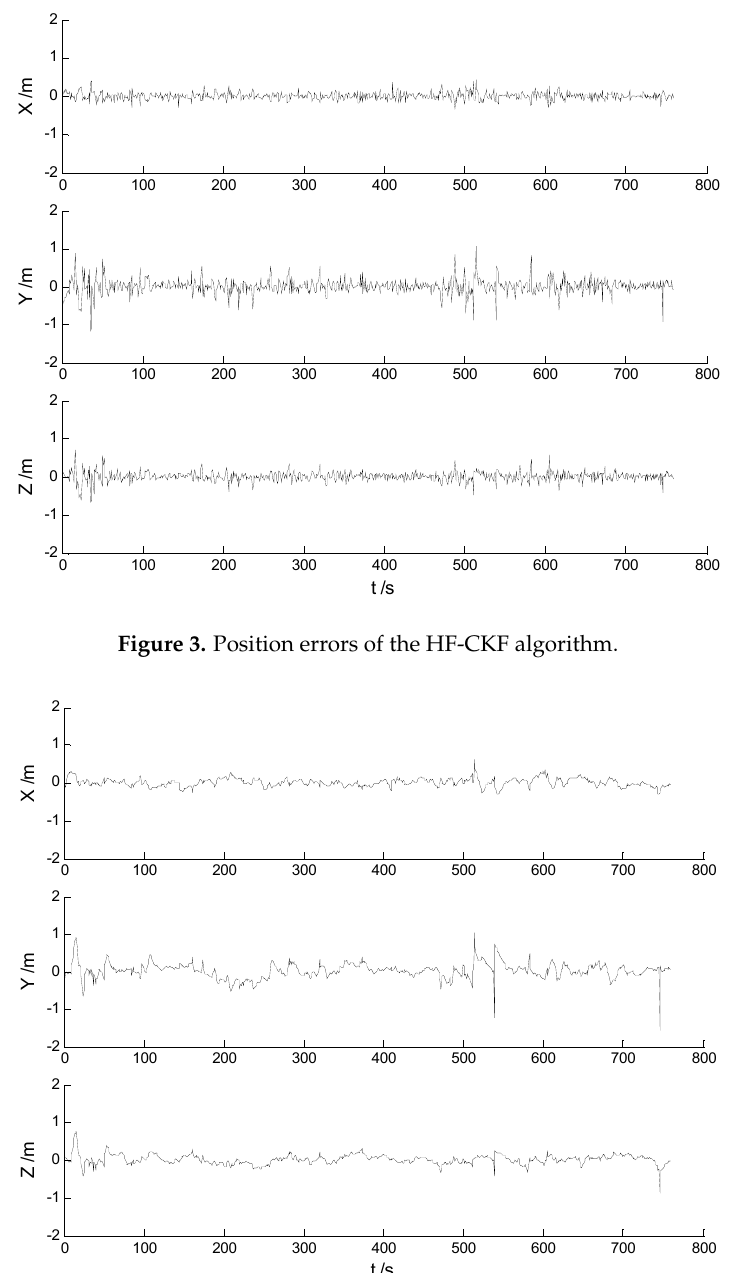
Figure 4. Position errors of the MF-CKF algorithm.